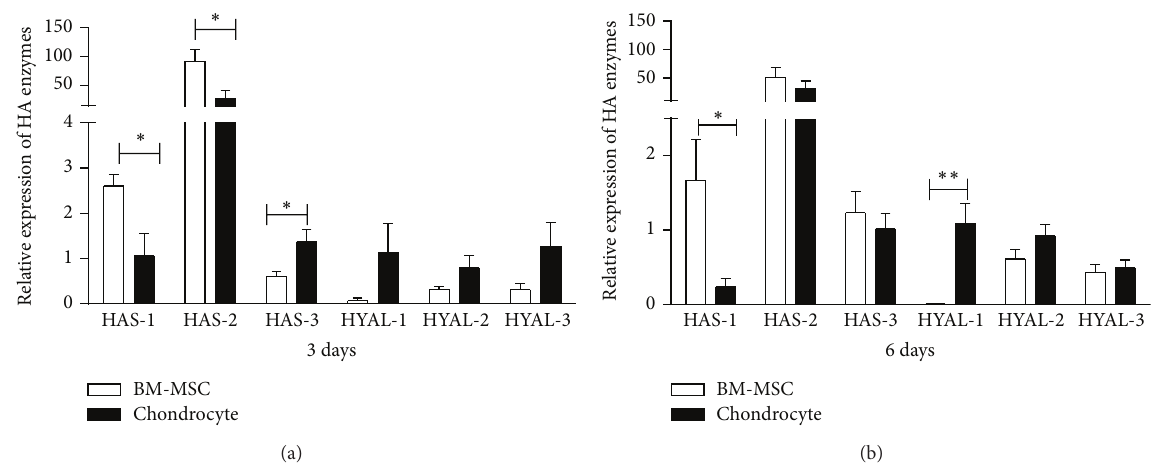
Figure 3: mRNA expression of hyaluronan enzymes by BM-MSCs and OA-chondrocytes. Relative mRNA expression of hyaluronan-related enzymes after 3 days (a) or 6 days (b) in monoculture. Bars represent the mean ± SEM of hyaluronan synthase- (HAS-) 1, HAS-2, and HAS-3 and hyaluronidase- (HYAL-) 2 and HYAL-3 mRNA expression. All fold changes were calculated relative to a calibrator sample. Statistical significance based on unpaired t -test was set according to the number of asterisks, as follows: ∗ 𝑃 ≤ 0.05 , ∗∗ 𝑃 ≤ 0.001